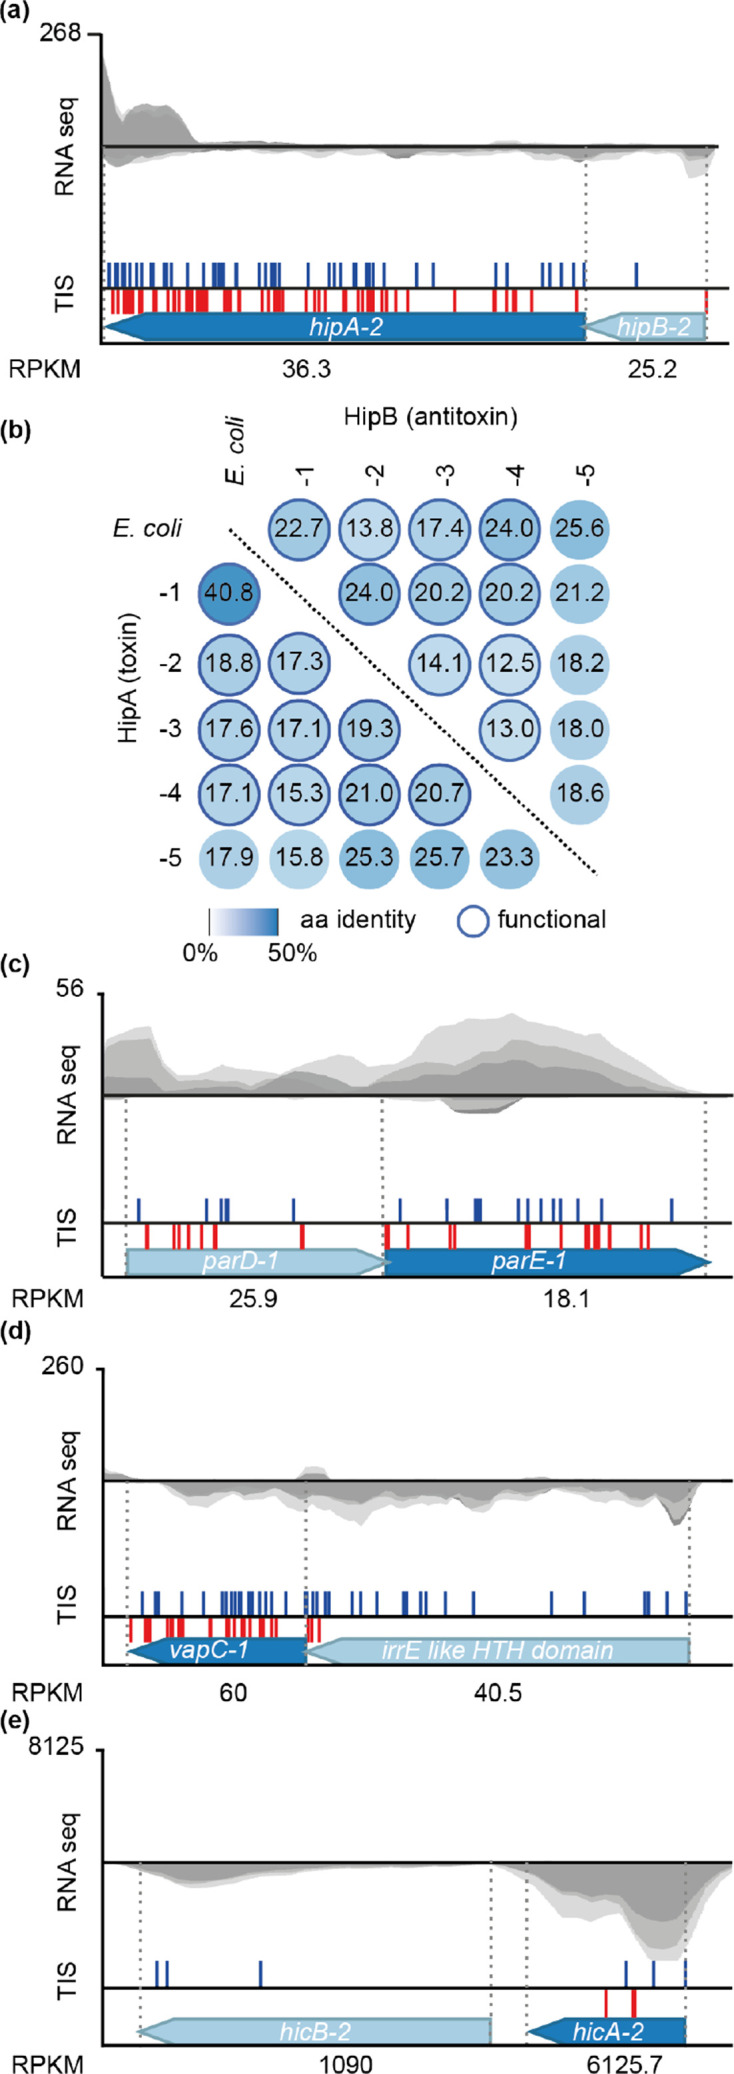
Type II systems are abundant in
Serratia
. (a) An example of transposon insertions (TIS, blue and red lines indicate insertions in the top or bottom strand, respectively), expression levels (n=3) as grey traces and quantified as RPKM, and organization of the genes encoding the HipAB-2 system. (b) Amino acid sequence similarity of the five
Serratia
 HipAB systems and the
E. coli
 K-12 HipAB across the entire length of the protein. Dark outer circles indicate a functional system. (c, d, e) Schematics of the non-functional parDE locus (c) and the functional (d) vapBC-1 and (e) hicAB-2 loci.